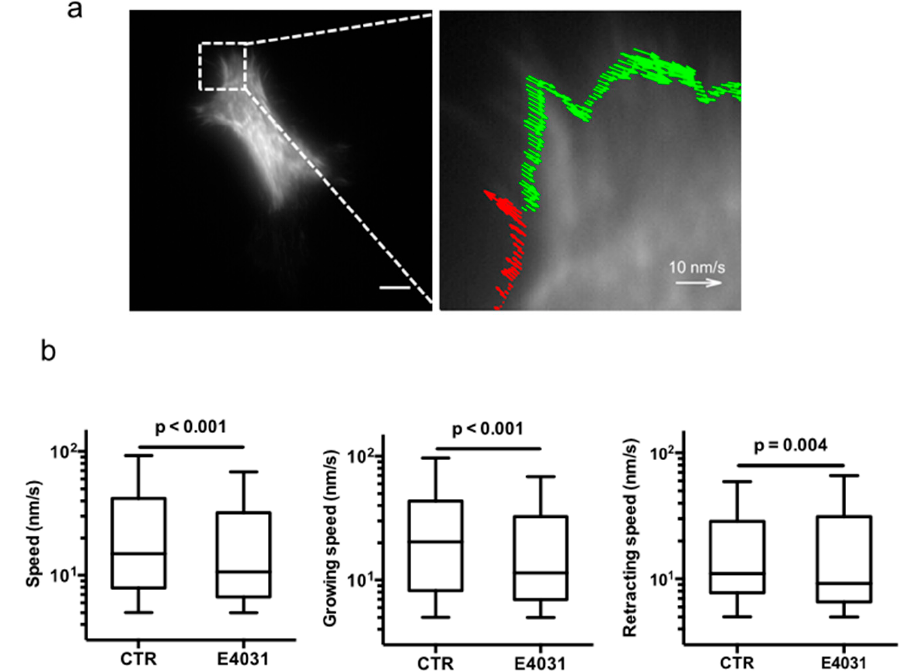
Figure 6. Actin dynamics in PANC-1 cells cultured onto DM plus Hypo-PSC-CM. ( a ) Representative total internal reflection fluorescence (TIRF) image of live GFP Life-Act transfected PANC-1 cells in control conditions (CTR), after Hypo-PSC-CM stimulation. (Scale bar: 10 µ m). The time series (120 images at 1 Hz) were analyzed by STICS, to build local velocity maps within the cell perimeter, as shown in the enlargement (right panel). Red and green arrows indicate growing and retracting speed, respectively. ( b ) Distributions of filopodia polymerization speed (left panel), filopodia growing and retraction speed calculated as velocities pointing outward (middle panel) and inward (right panel) the cell perimeters for cells in CTR and in the presence of 40 µ M E4031 (E4031). Boxes include central 50% of data points, the horizontal lines denote minimum value, median, and maximum value. At least 15 time series per condition from three independent experiments were analyzed. All p -values were determined by a Mann–Whitney test (significant level set to p < 0.05), or for data deviating from normality by a Kolmogorov–Smirnov test.